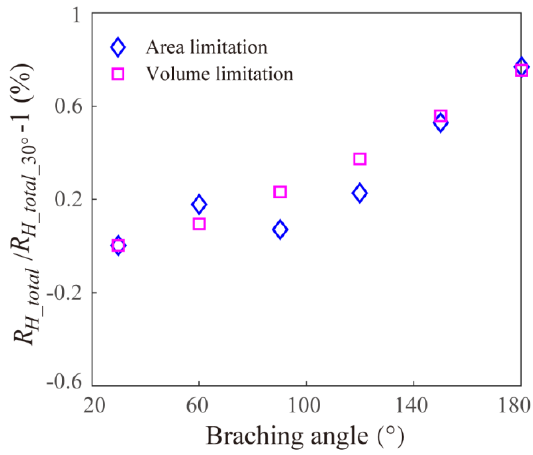
Figure 3. Effect of branching angle on the total fluidic resistance of EOF within two Y-shaped microchannel bifurcations with different limitations.